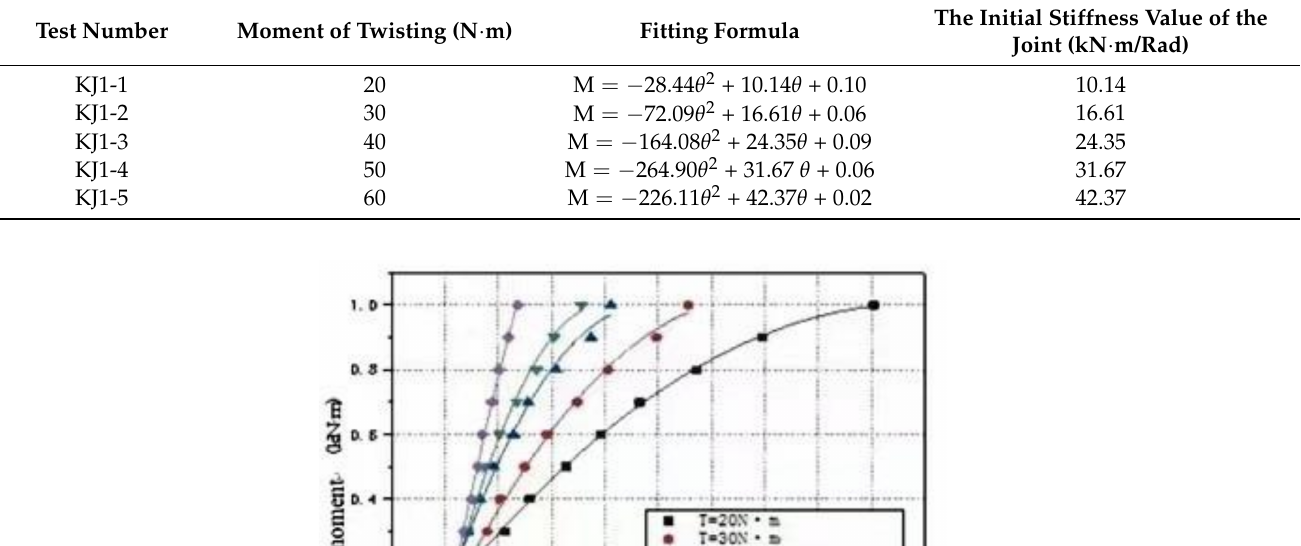
Table 3. Quadratic function fitting right angle fastener connection moment–rotation function formula.